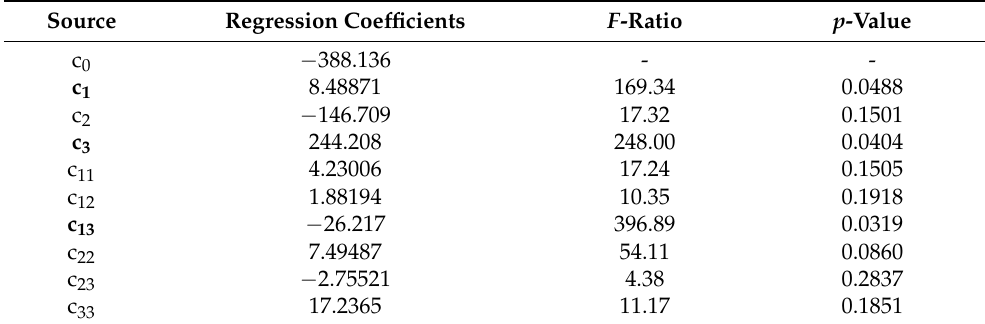
Table 2. ANOVA of the regression coefficients (Equation (1)) for the droplet size of the W/O emulsions. Statistically significant terms ( p < 0.05) are written in